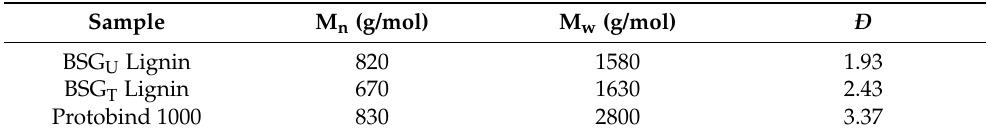
Table 4. Number average molecular weight (M n ), weight average molecular weight (M w ), and polydispersity index ( Ð ) of all examined lignins (samples were eluted after acetylation; reported values are relative to polystyrene